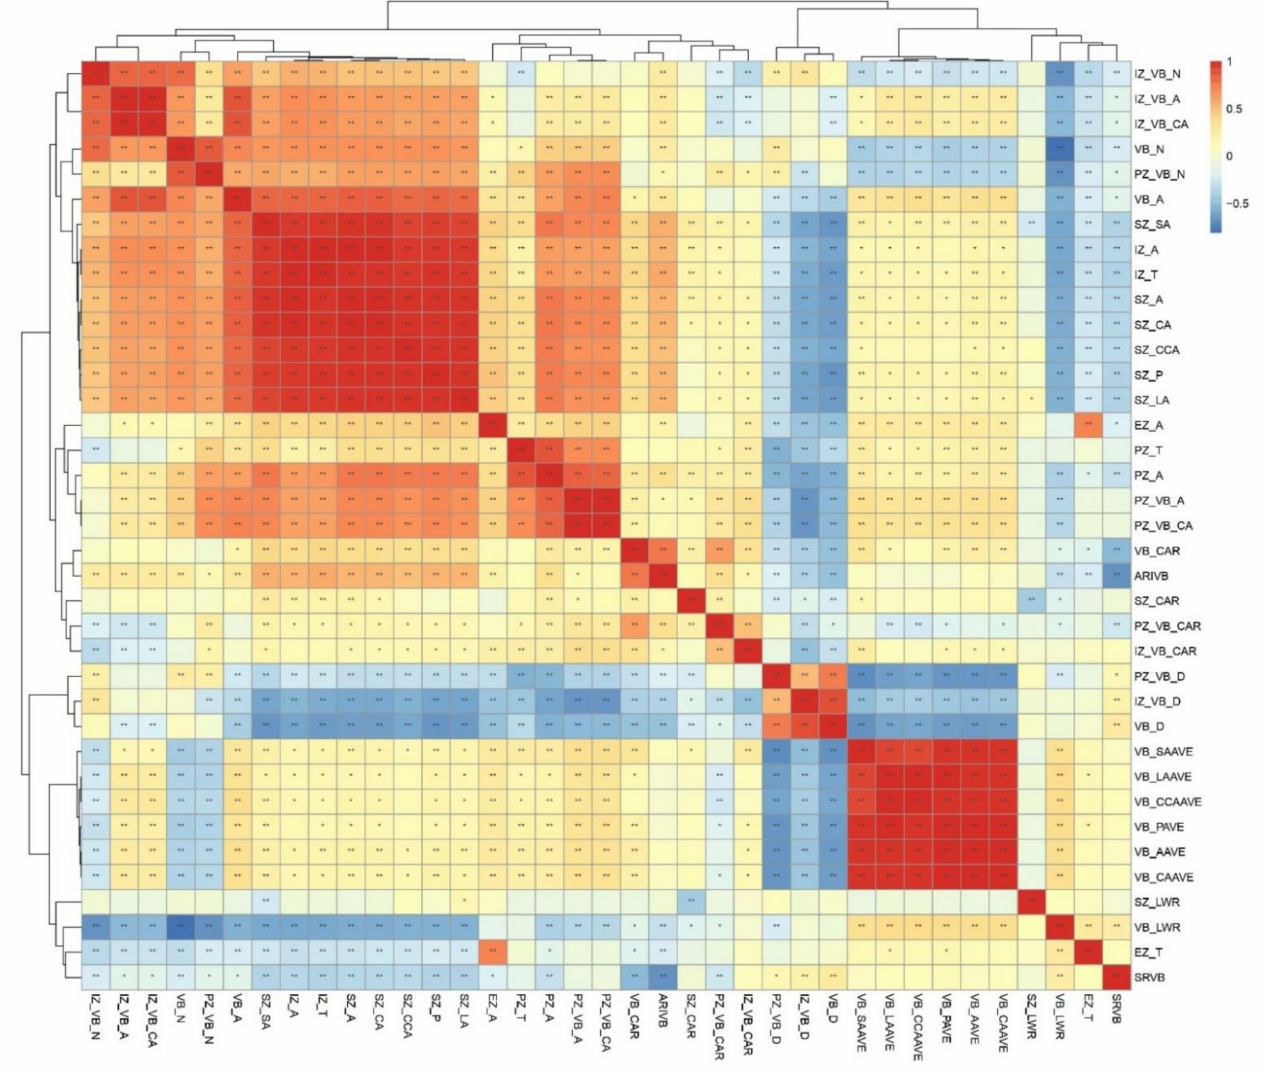
Figure 2. Spearman’s correlations of the 36 phenotypic traits of the shank basal internodes in natural maize populations in two environments. ** p -value ≤ 0.01, * p -value ≤